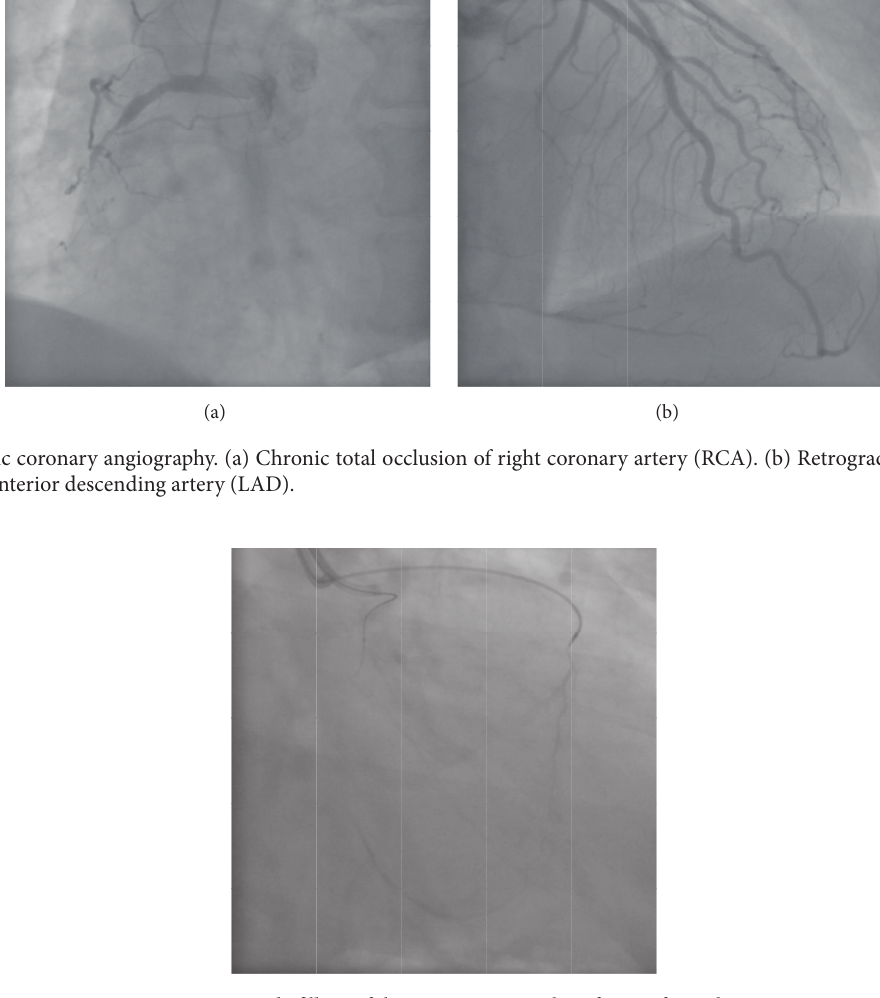
Figure 2: Retrograde filling of the RCA via a septal perforator from the